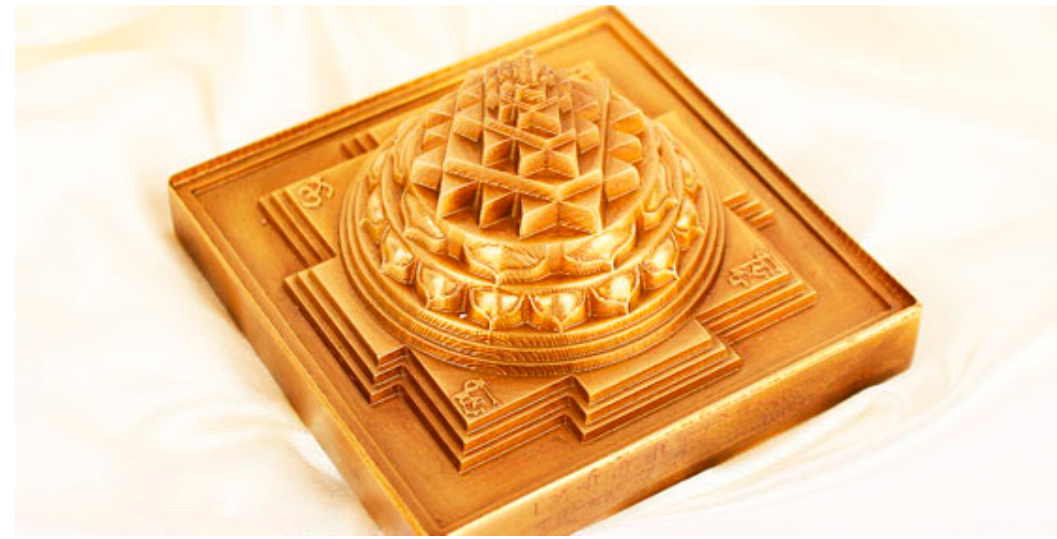
Figure 4. Ś r ī cakra Meru, https://www.srilalithambika.org/poojas.php (accessed on 5 July 2021). Figure 4. ´Sr¯ıcakra Meru, https://www.srilalithambika.org/poojas.php (accessed on 5 July